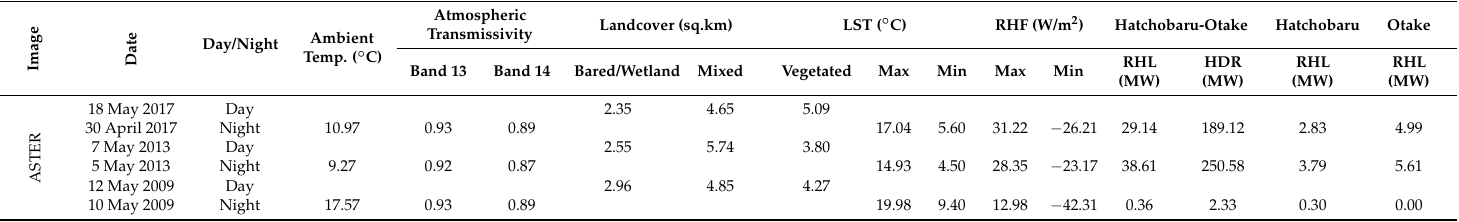
Notes. The total RHL was calculated after removing the RHL using the pixels with the background LST (average). LST—land surface temperature; RHF—radiative heat flux; RHL—radiative heat loss; HDR—heat discharge